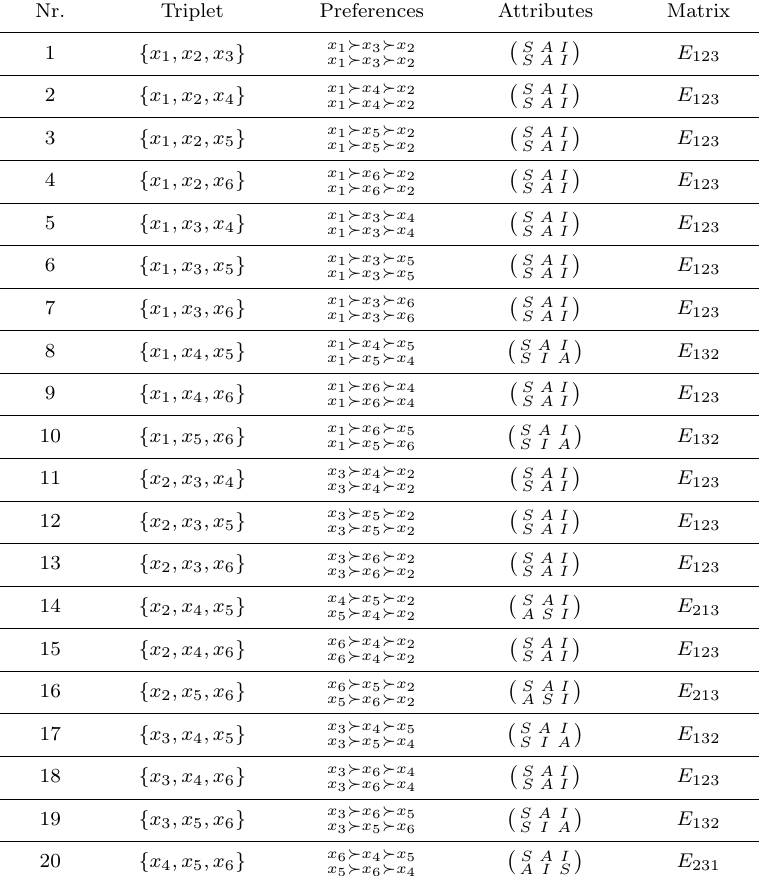
Table 4. 20 possible choices of 3 variables from x 1 − x 6 with first expert evaluations. Nr. Triplet Preferences Attributes